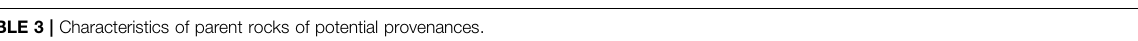
TABLE 3 | Characteristics of parent rocks of potential